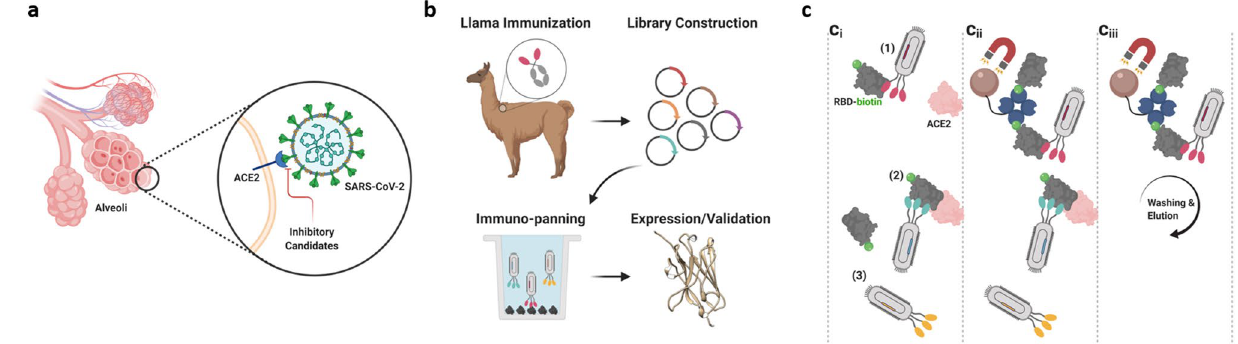
Figure 1. Overview of the therapeutic potential and isolation of nanobodies targeting the SARS-CoV-2 RBD:ACE2 interaction. ( a ) Illustration of the structure of SARS-CoV-2 spike protein, with receptor binding domain in contact with the human ACE2 receptor on the surface of a lung epithelial cell. A major therapeutic goal is to develop inhibitory agents that disrupt the interaction between the spike protein and the human